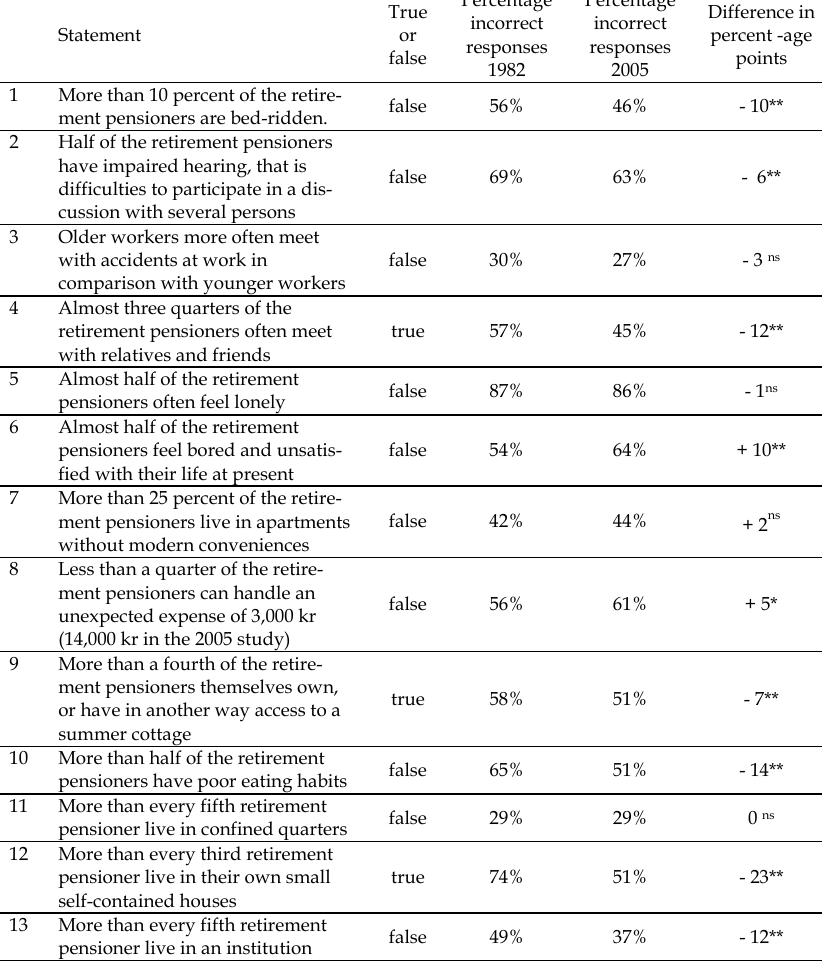
Table 1 . Comparing Quiz results in 1982 and